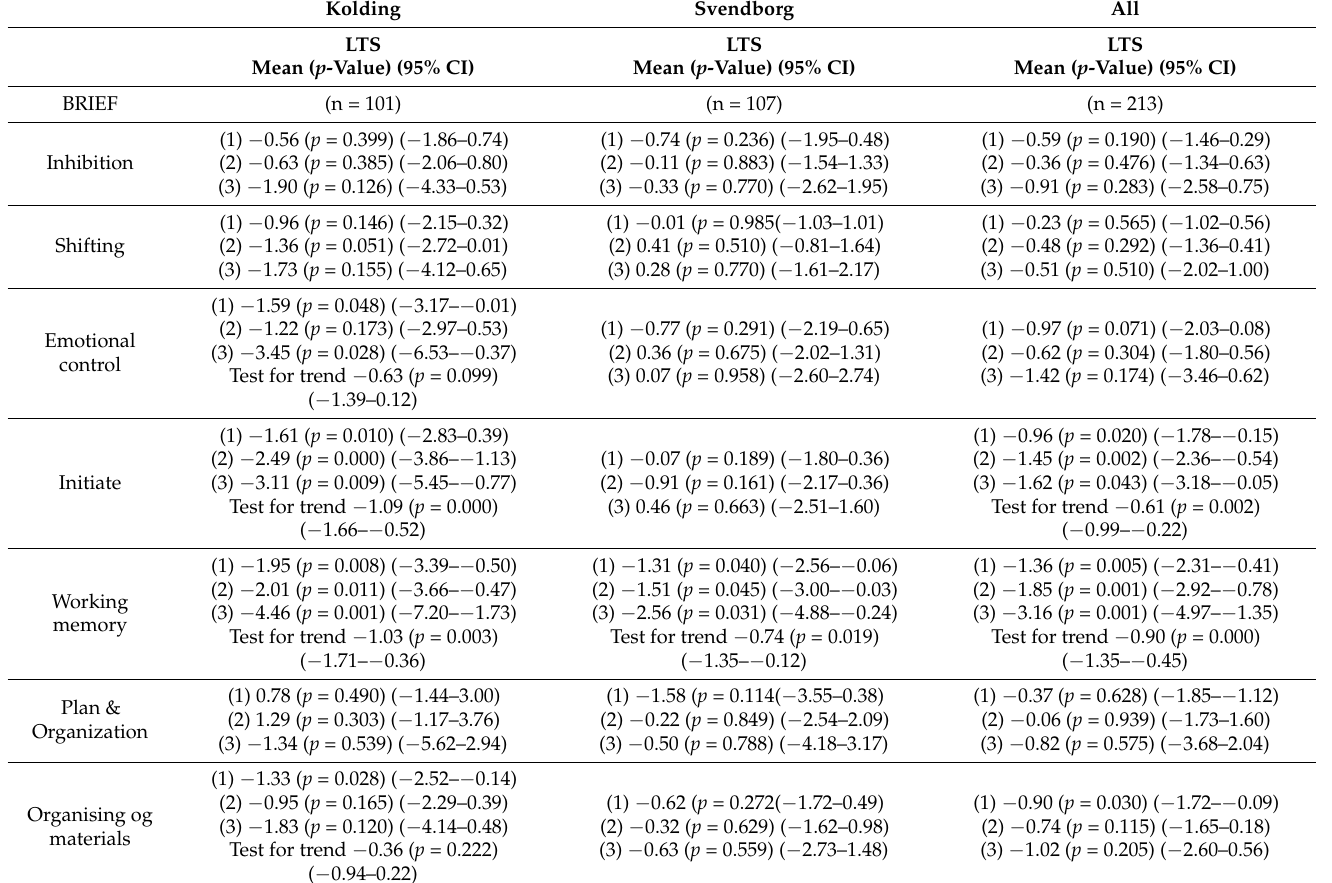
Table 3. BRIEF—Results from Kolding & Svendborg and all together. Results are presented with mean, p -values and 95% confidence interval (CI). Grey boxes: Significant values. Categories for LTS: Cat.0: =0 (not shown, reference cat. = 0), Cat.1: ≥ 0.5–<1.5, Cat.2: ≥ 1.5–<2.5, Cat.3: ≥ 2.5–<5 times per